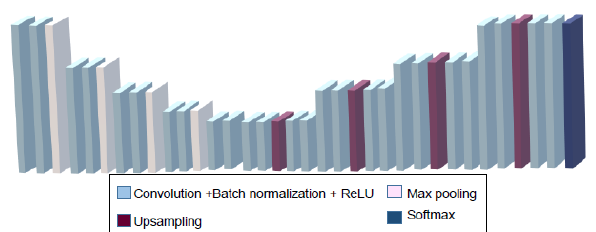
Figure 2 . Architecture of encoder-decoder convolutional neural